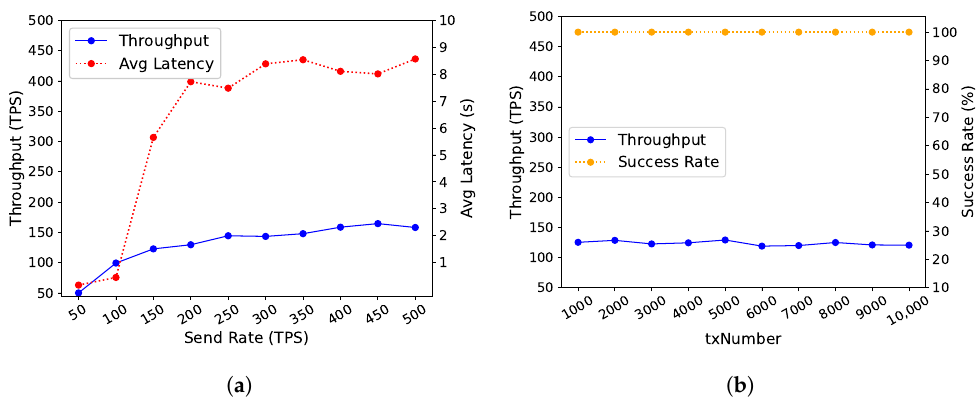
Figure 8. Performance of WRITE to HLF’s ledgers. ( a ) Performance of Different Send Rates with a TxNumber Equal to 2000. ( b ) Performance of Different TxNumber with a Send Rate Equal to 150.